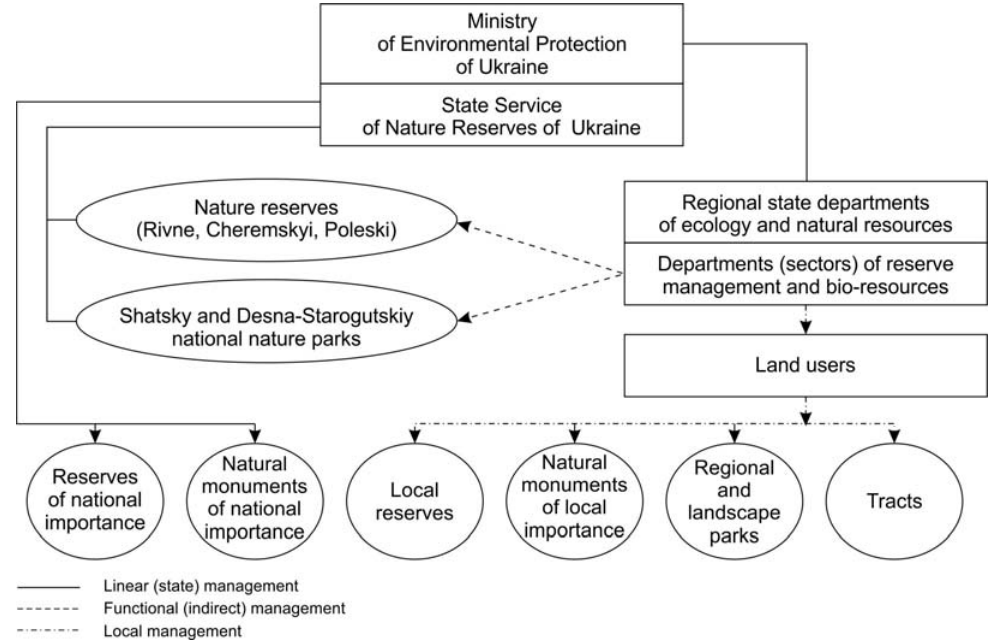
Fig 2. System of management of nature